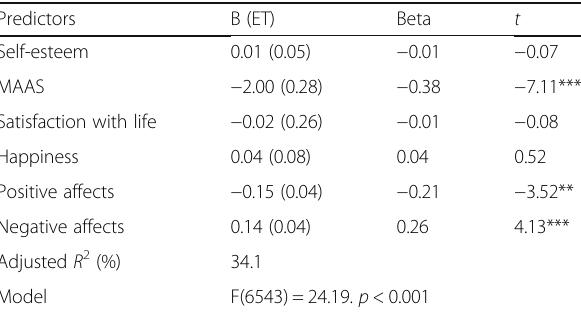
Table 4 Predictors of the MWQ